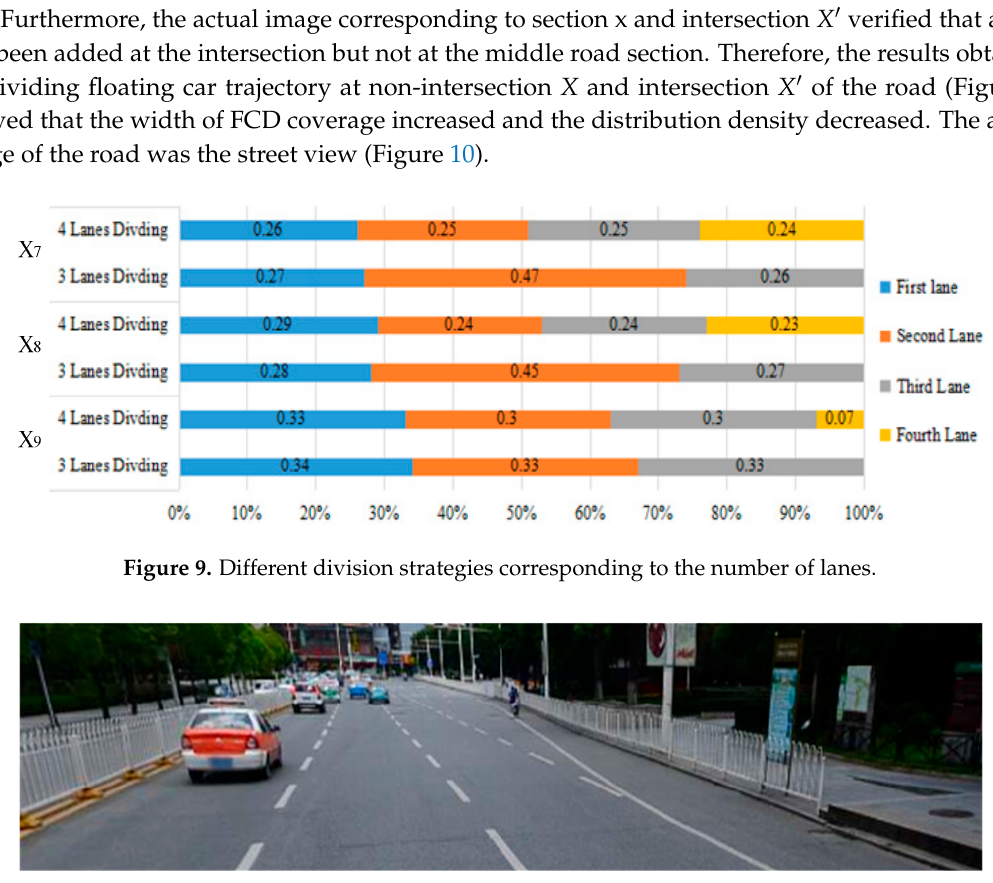
Figure 10. Corresponding image of road segment X and intersection segment X ′ .